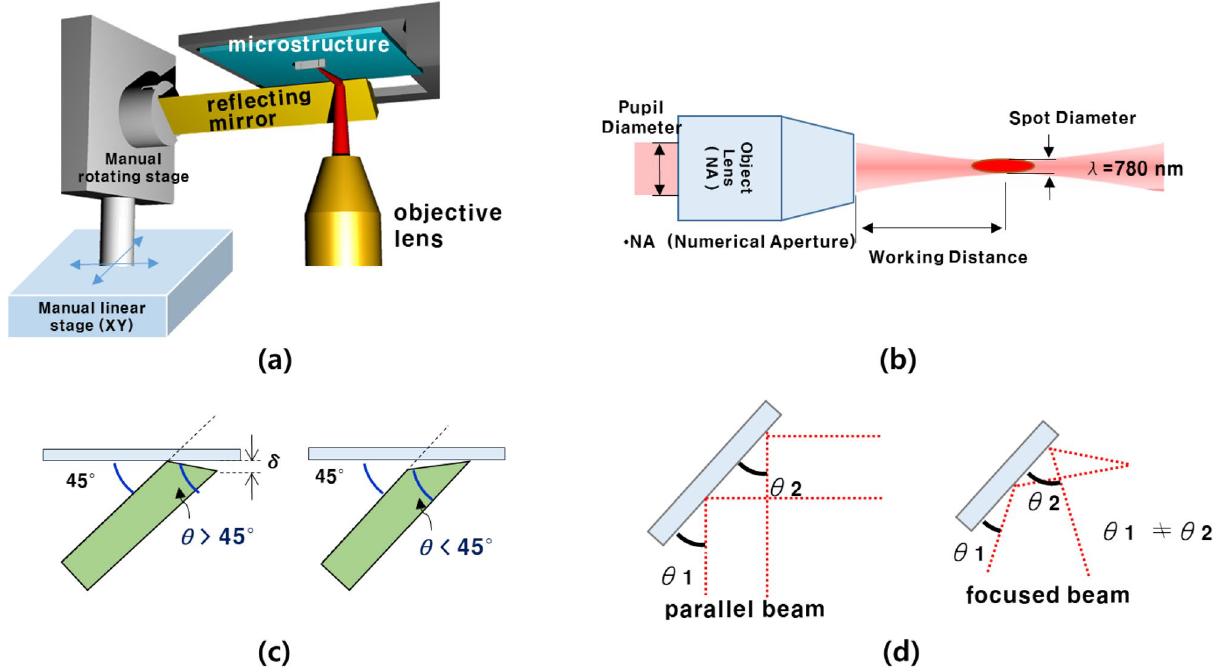
Figure 2. ( a ) Schematic diagram of the mirror system, which consists of a gold-coated mirror and NA 0.3 objective lens. The mirror reflects a femtosecond laser to change the beam. ( b ) Schematic illustration of the